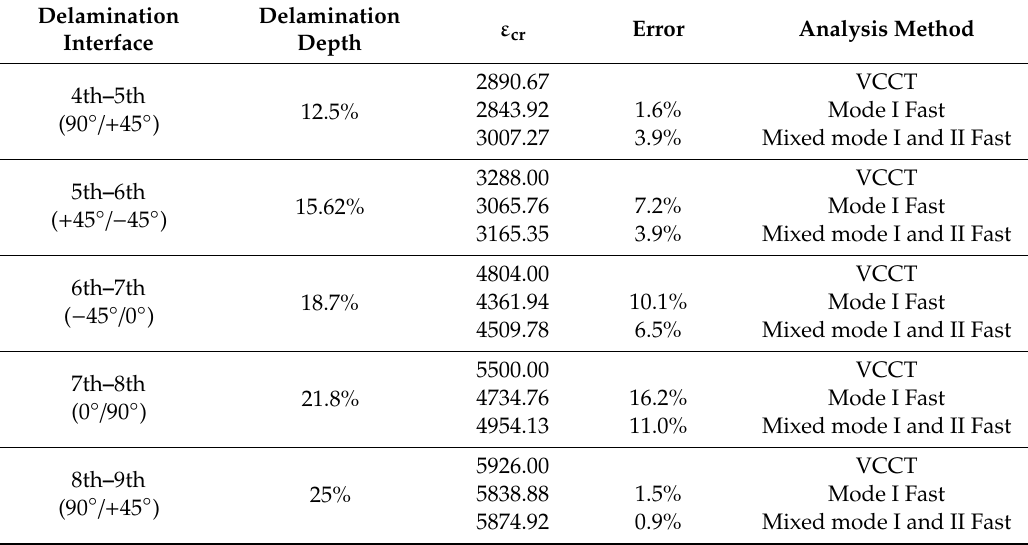
Table 5. Results summary for SS#4 damage configuration (17.5 mm radius